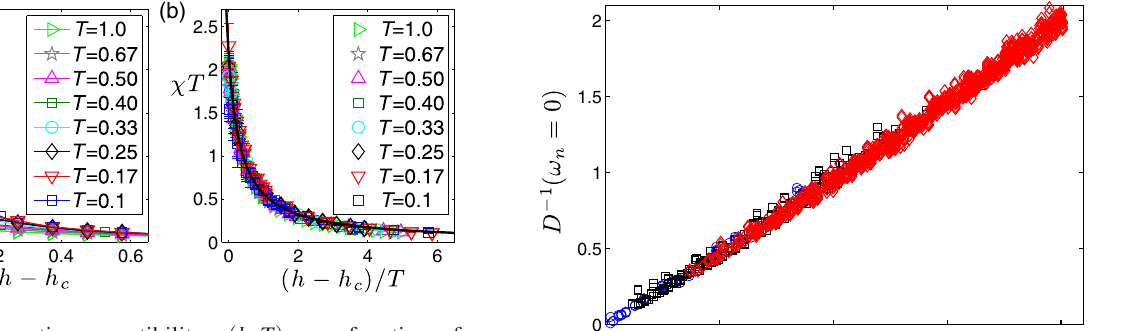
FIG. 8. Comparison between the thermodynamic ( ω functional approximant A , from Eq. (6), and the nematic correlator D . Data shown represent L ¼ 16 , 20, and 24, h ¼ 3 . 525 , 3.7, 3.9, and 4.1, and temperatures T ¼ 1 . 0 , 0.67, 0.5, 0.33, 0.25, 0.17, 0.13, 0.1, 0.05, and 0.025. To exhibit the momentum dependence, we use blue circles for q ¼ 0 (71 data points), black squares for j q j ¼ ð 2 π =L Þ and ð 2 π =L Þ points), and red diamonds for all other q (1916 data points).